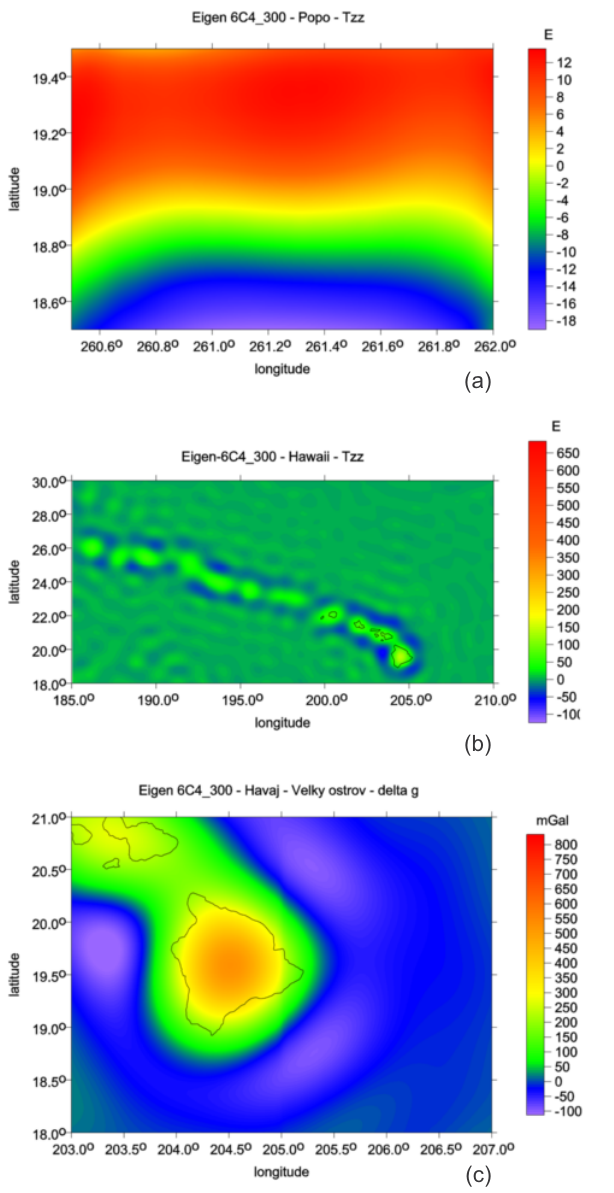
Figures 8 (same column, top to bottom). The truncation of EIGEN Figure 9 (same, column, top to bottom). (a) Ground tracks of satel- 6C4 at degree and order 300 to simulate a model with satellite lite missions GRACE (red) and GOCE (blue) near the South Pole. (GOCE) data only. The values of T around Popocatepetl (a) and The latitude turning points result from orbit inclination, which is zz at Hawaiian Islands (b) and D g for the Big Island of Hawaii (c). To be 89° for GRACE and 96.7° for GOCE. The ground track points of compared to Figures 5a and 4a,d. both missions are displayed for 5 days in December 2010. (b) Surface density of observation points for GRACE (red) and GOCE (blue). Here the surface density is defined as the number of observations per unit area and it is displayed as function of latitude (here the den- sity is normalized by its value on the equator). The y -axis is shown linear (upper plot) or logarithmic (lower plot). (c) Geoid height error (in meters), as a function of geographic location, of a satellite- only gravity field solution ASU-CHAMP-0309 computed from 7 years of CHAMP GPS data (from Bezd ě k et al.